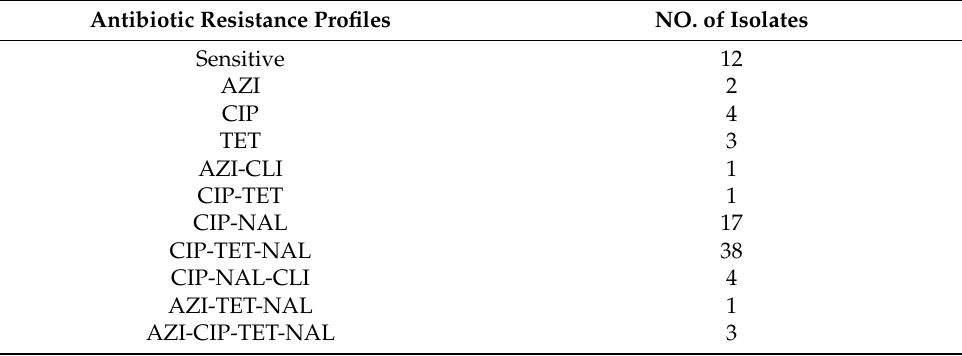
Table 3. Antibiotic resistance profiles of 100 C. jejuni